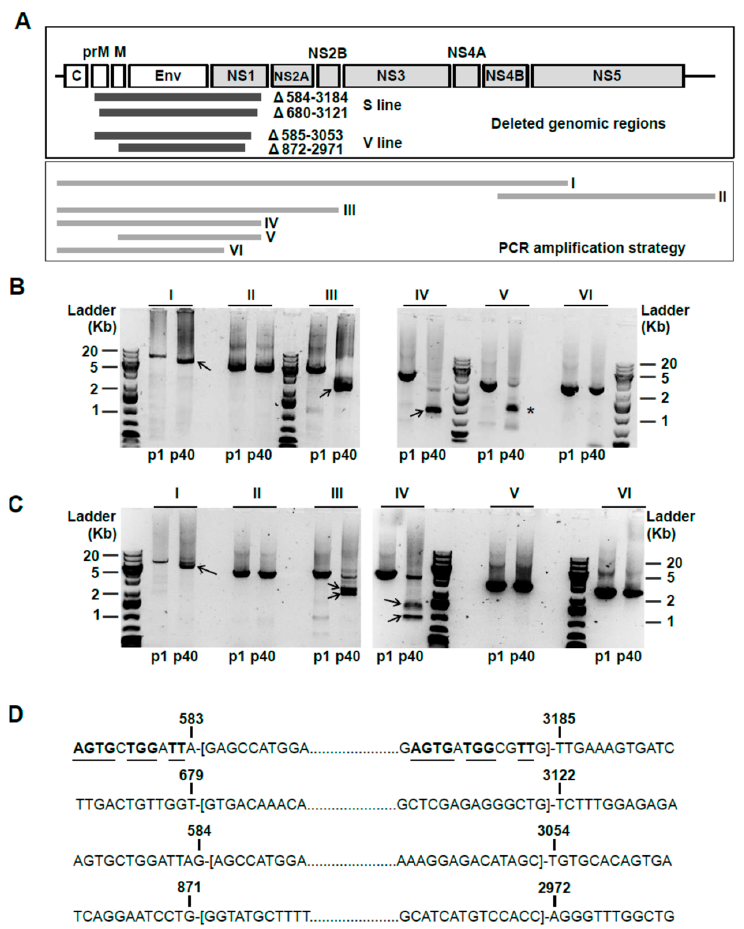
Figure 2. USUV genomes containing large deletions in the 5’ end are detected in persistently-infected cells. ( A ) Schematic representation of USUV genome, PCR amplification strategy, and deletions identified. Top panel, illustration of USUV genome. Each box represents a different viral protein-coding region. White boxes represent genomic sequences encoding structural proteins (C, capsid; M, membrane protein; PrM, M precursor; Env, envelope) and grey boxes depict non-structural proteins (NS1 to NS5). Different deletions are indicated by a thick dark grey line below the corresponding truncated sequence. Bottom panel, PCR amplification strategy (only shown those corresponding to PCR gel analyses below). Each predicted amplicon is represented as a thick light grey line (I to VI). B and C, amplification products of viral RNA extracted from persistently-infected cells at passage 40 (p40) or cells infected with wild type USUV (p1). Amplification of viral RNA from S ( B ) and V cells ( C ) and compared to USUV wild type. The amplification products were run on a 1.5% agarose gel in the presence of 0.5× TBE for 35 min. PCR bands in persistently-infected cells (p40) of lower molecular